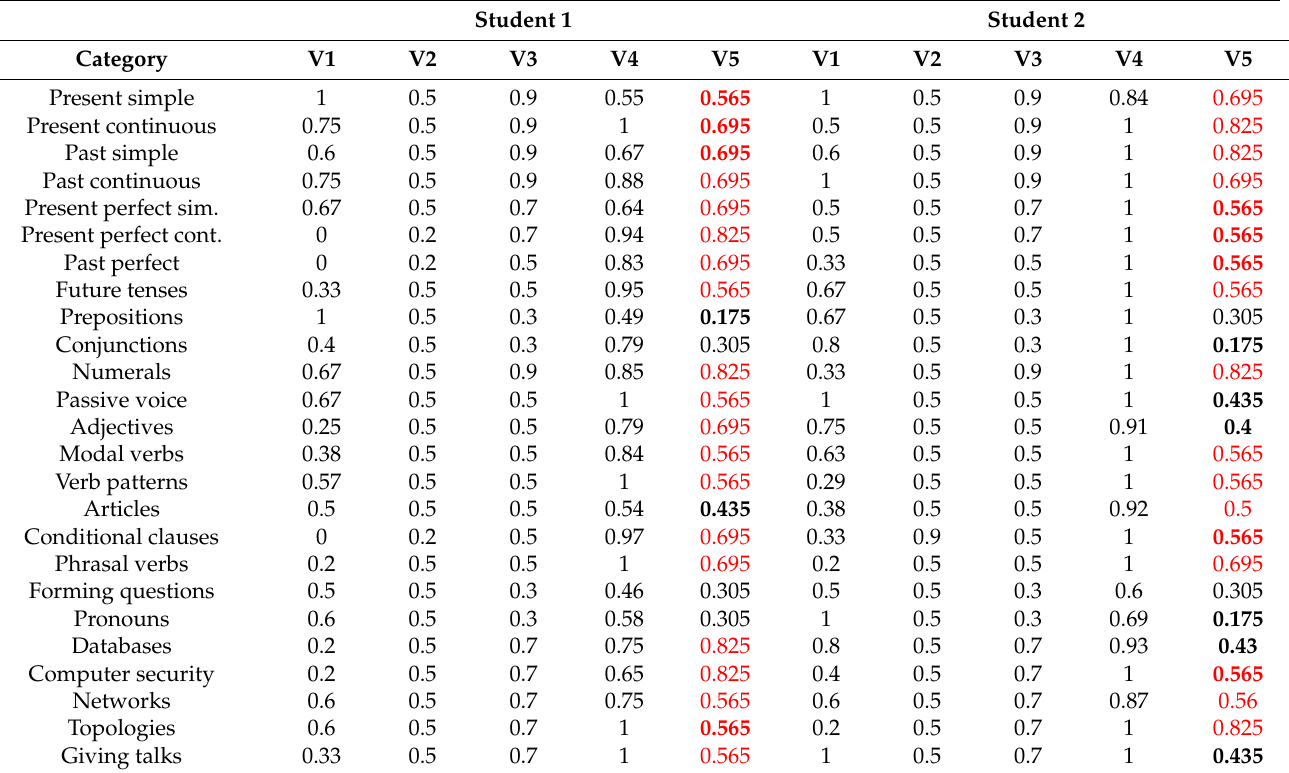
Table 3. Comparison of values achieved in the didactic test by two students. If V5 value is in red, the category is marked “ not-completed ”, if in black, the category is marked “ completed ”. Bold font means at least a 10% better achieved result.